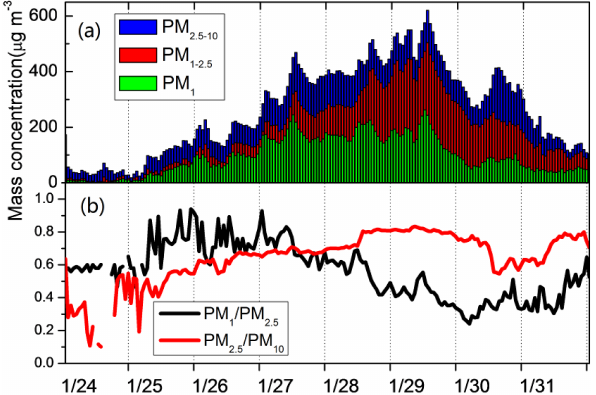
Figure 1. Time series of (a) mass concentrations of PM 1 , PM 1 − 2 . 5 and PM 2 . 5 − 10 ; (b) mass ratios of PM 1 / PM 2 . 5 and PM 2 . 5 / PM 10 .